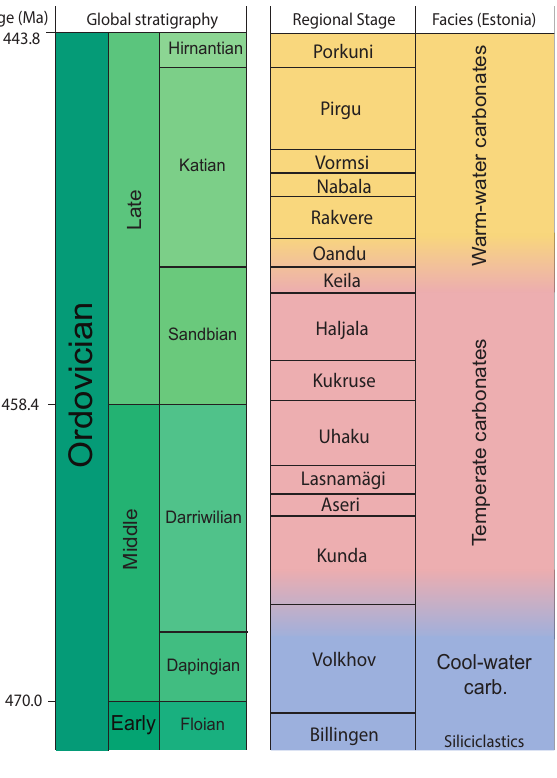
Fig. 2. Regional and international stratigraphy of the studied interval, showing transition from cool­water to warm­water carbonate deposits (modified after Toom et al.